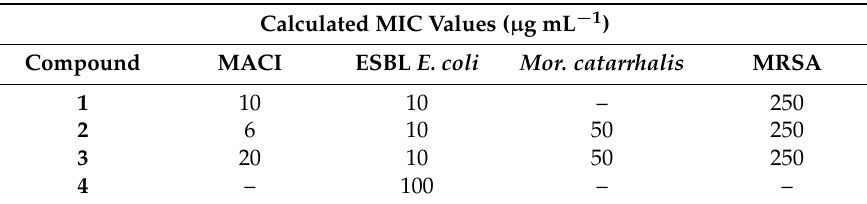
Table 1. Antibacterial activity of compounds 1 – 4 expressed in MIC values.